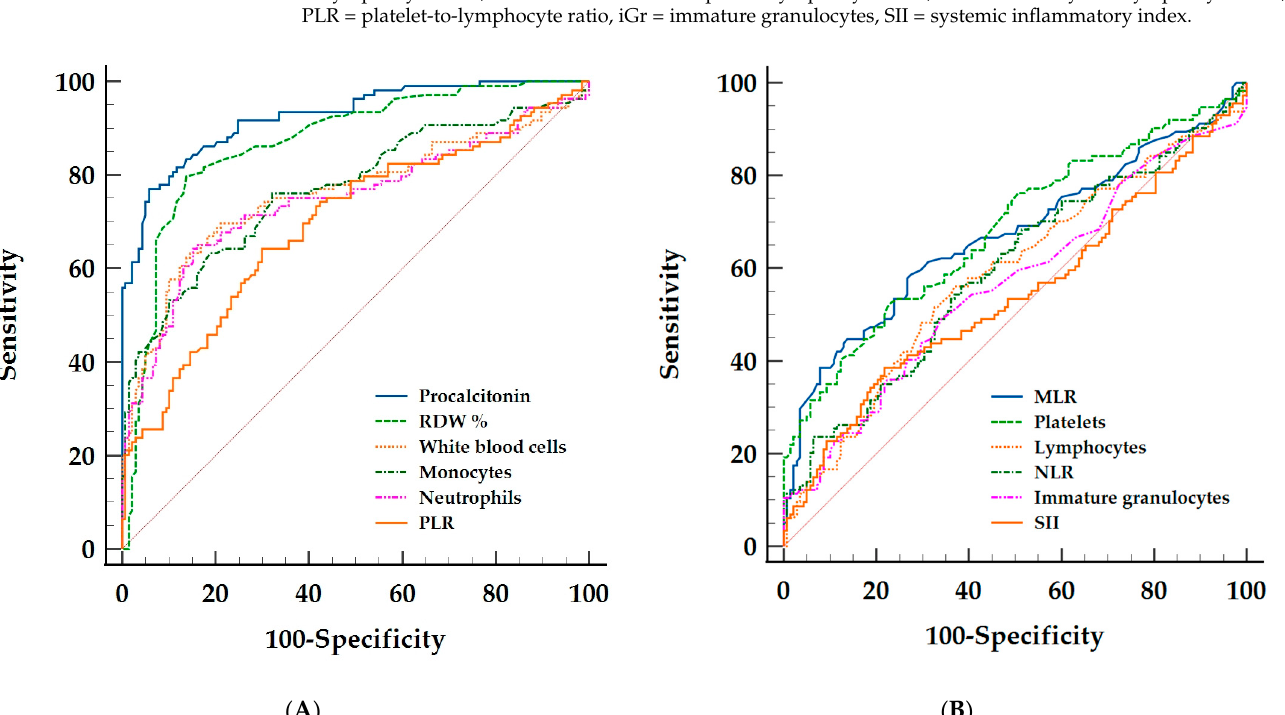
Figure 2. Discriminative analysis for the diagnosis of bacterial versus viral sepsis of procalcitonin and hematological parameters. ( A ) Parameters with an area under the curve >0.7; ( B ) Parameters with an area under the curve <0.7. Bacterial sepsis group: 124 patients, COVID-19 sepsis group: 138 patients. RDW% = red blood cell distribution width; PLR = platelet-to-lymphocyte ratio; MLR = monocyte-to-lymphocyte ratio; NLR = neutrophil-to-lymphocyte ratio; SII = systemic inflammatory index.